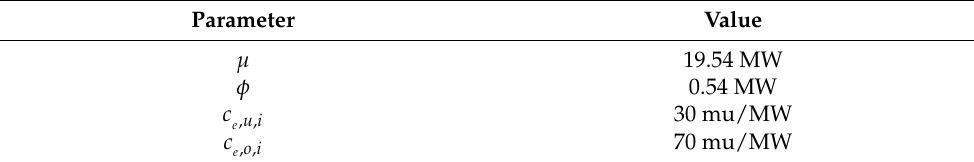
Table 4. Parameters taken for the controllable load cost function